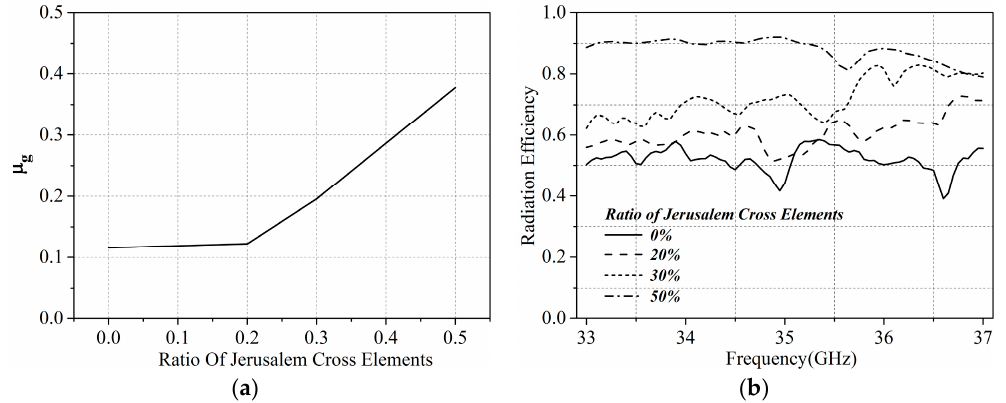
Figure 7. ( a ) Calculated average mutual coherence μ g and ( b ) the radiation efficiency of different MAAs with different filling ratios of CJC elements.